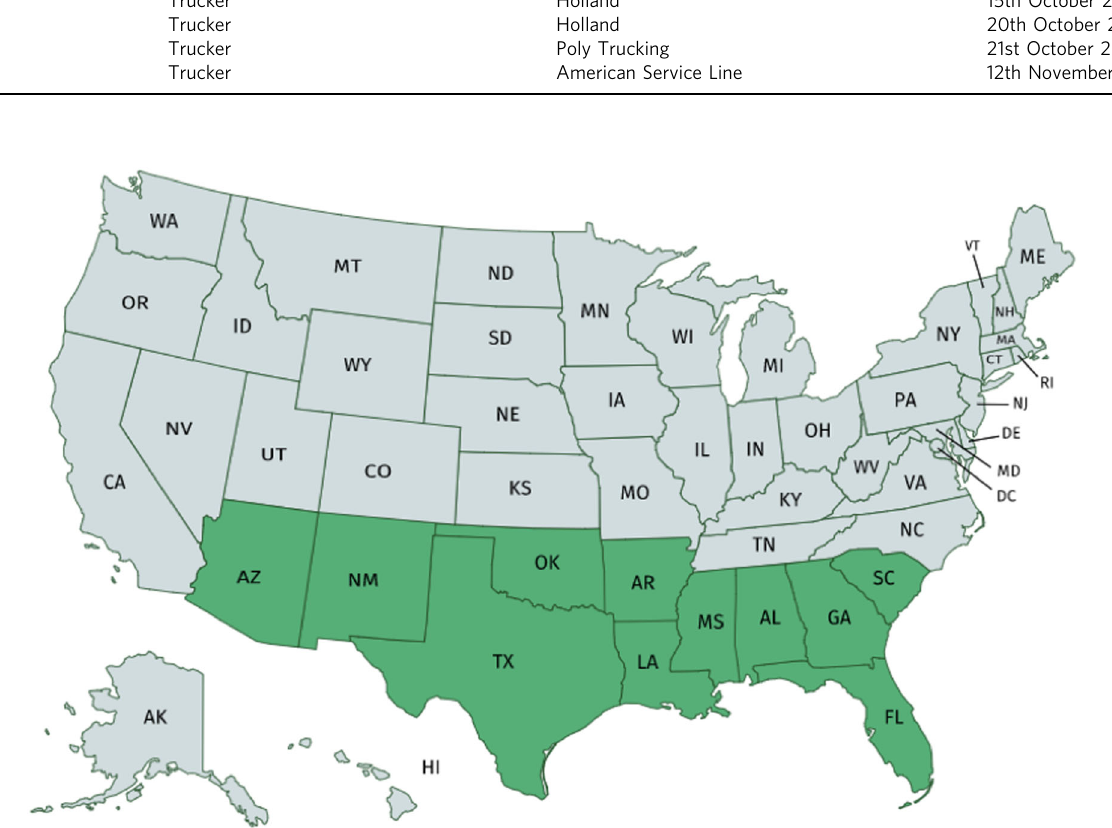
Fig. 2 Highlighted southern sun-belt states where a transfer-hub model may fi rst be